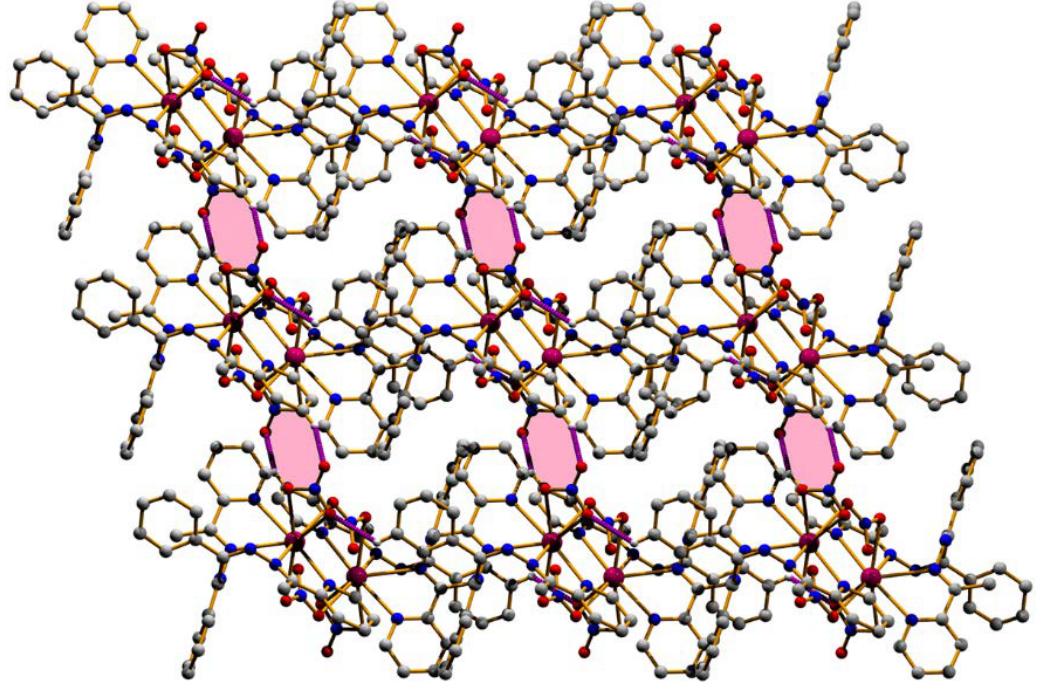
Figure 6. Supramolecular self-assembly generated through weak C‒H∙∙∙O hydrogen bonds in the (110) plane.